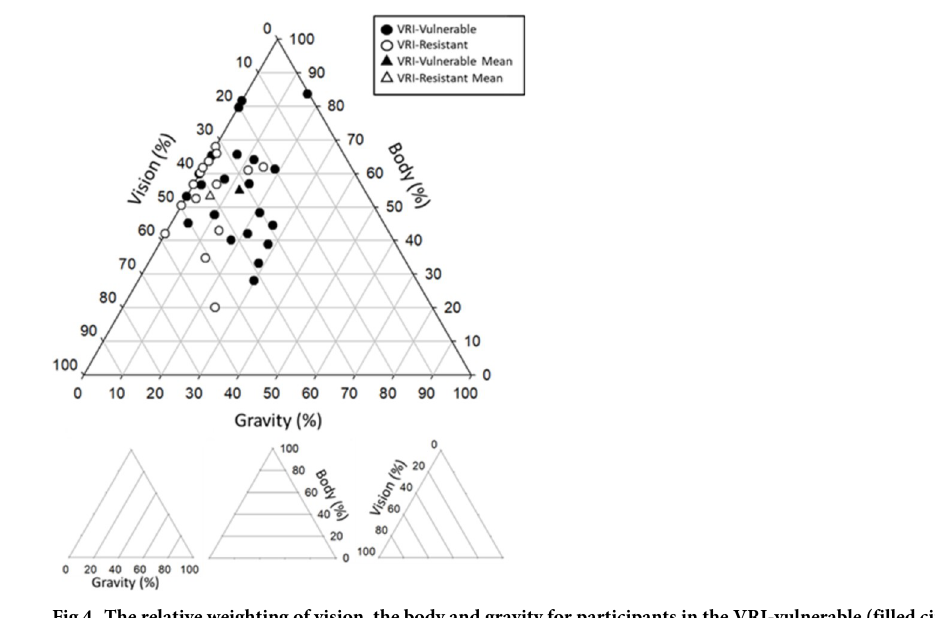
Fig 4. The relative weighting of vision, the body and gravity for participants in the VRI-vulnerable (filled circles) and VRI-resistant (open circles) groups are plotted as a ternary plot. Means are shown as filled (VRI-vulnerable) and open triangles (VRI-resistant). The inset below the plot is a key indicating how to read a ternary plot. The gravity weightings are read along the diagonal lines starting at the bottom left of the triangle where 0% gravity weighting corresponds to the left-most diagonal line. The body weights are read along the horizontal lines with 0% body weighting corresponding to the bottom-most horizontal line. The visual weights are read along the diagonal lines starting at the apex of the triangle where 0% visual weight corresponds to the right-most diagonal